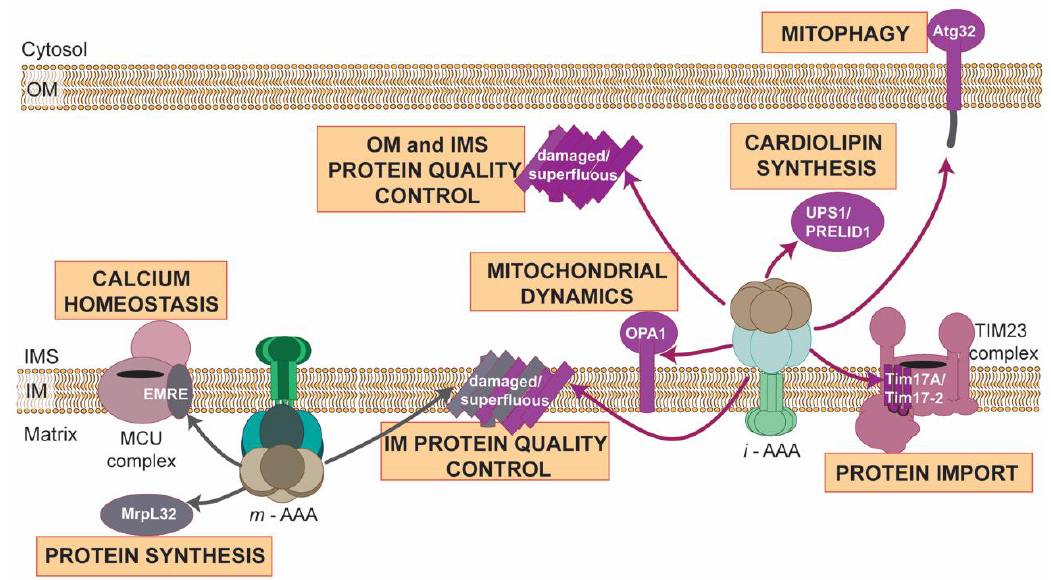
Figure 3. Multifaced activities of AAA proteases at mitochondria. Illustration summarizes spectrum of known proteolytic substrates of either yeast, mammalian or plant i -AAA (violet arrows) or m -AAA proteases (grey arrows), whose either processing or removal by AAA proteases modulate diverse mitochondrial functions. OM, outer membrane; IMS, intermembrane space; IM, inner membrane.